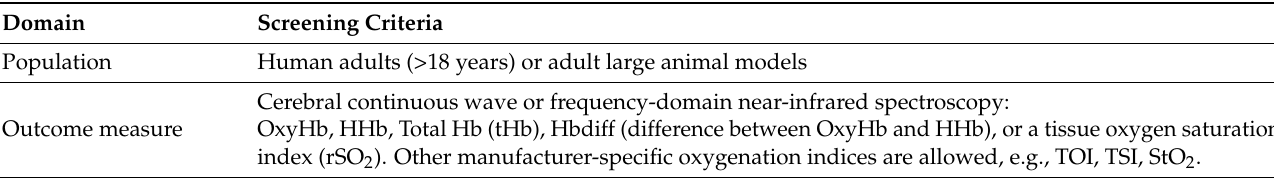
Table 1. Inclusion criteria for title and abstract, and full text screening. Studies were assessed in five domains: population, outcome measure, exposure, study quality and type, and study methodology. Hb, haemoglobin; HHb, deoxygenated haemoglobin; OxyHb, oxygenated haemoglobin; rSO 2 , re- gional tissue saturation of oxygen; StO 2 , tissue saturation of oxygen; TOI, tissue oxygenation index; TSI, tissue saturation